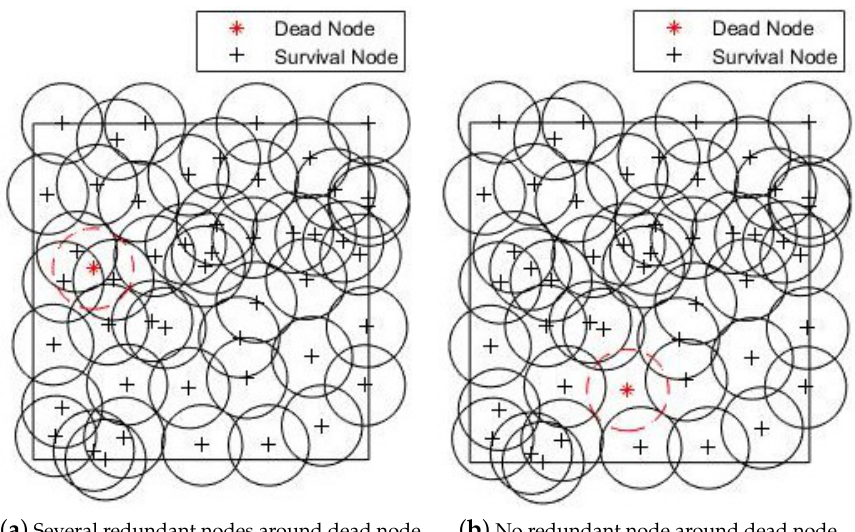
Figure 1. Figures with dead node at different